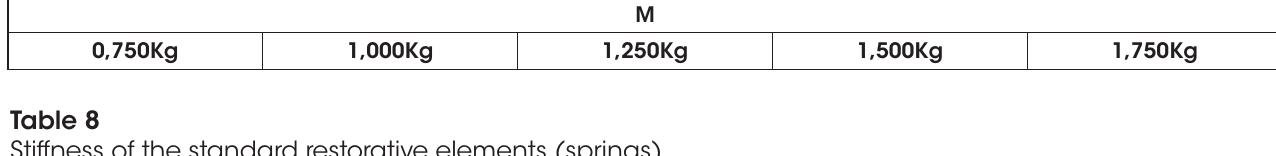
Stiffness of the standard restorative elements